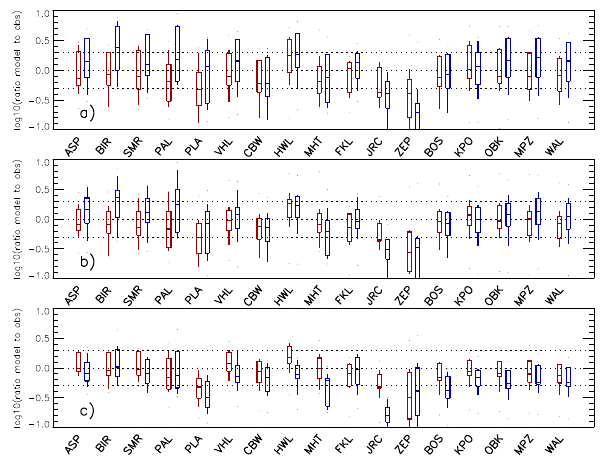
Figure 14. Box plots indicating the median, 25th and 75th per- centiles of model to observation ratio for (a) N 30 , (b) N 50 and (c) N 100 at the 17 low-altitude EUSAAR/GUAN sites. Winter and summer values are shown in blue and red respectively. The plots show the base-10 logarithm of the ratio, so a value of 1.0 means a factor of 10 high bias and a value of − 1.0 means a factor of 10 low bias. The dashed lines indicate where the model is within a fac- tor of 2 of the